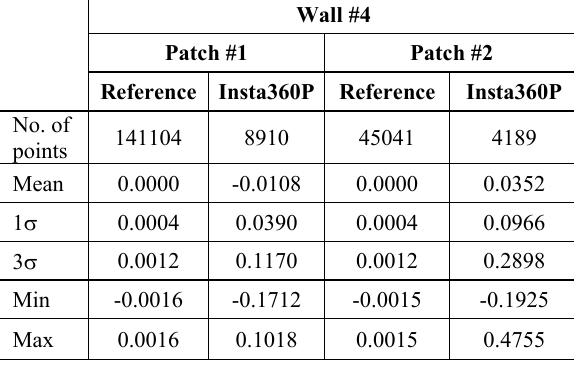
Table 4. Statistical results for surface patches on Wall 4.